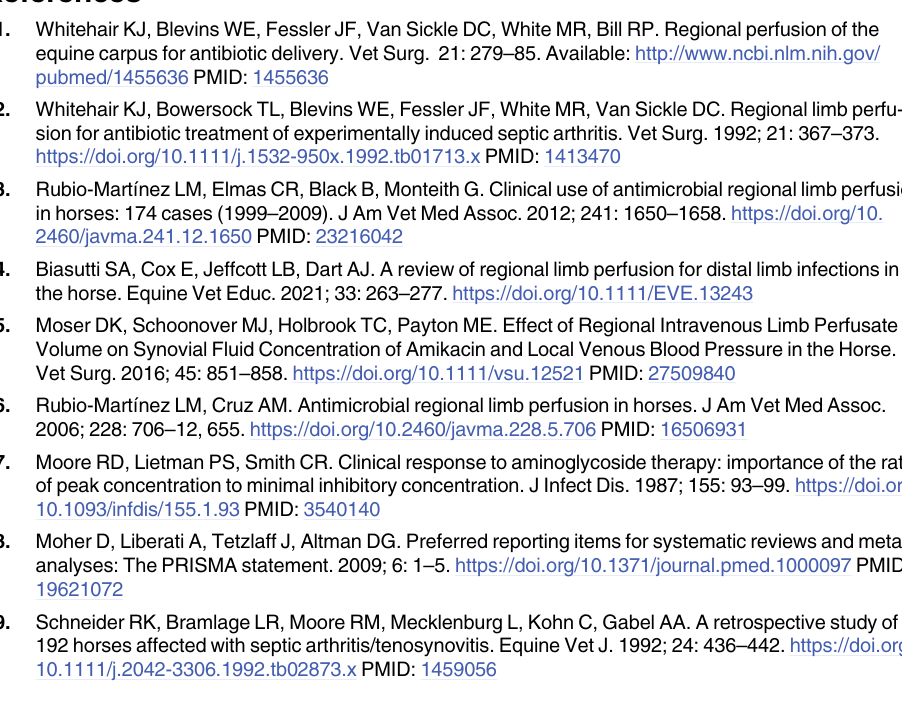
S2 Table. Values of ξ (n) in the formula (7) and the formula (12) for Q � 20. Modified from Wan et al. 2014. [14]. S3 Table. Values of η (n) in the formula (12) and the formula (15) for Q � 20, where n = 4 Q + 1. Modified from Wan et al. 2014.